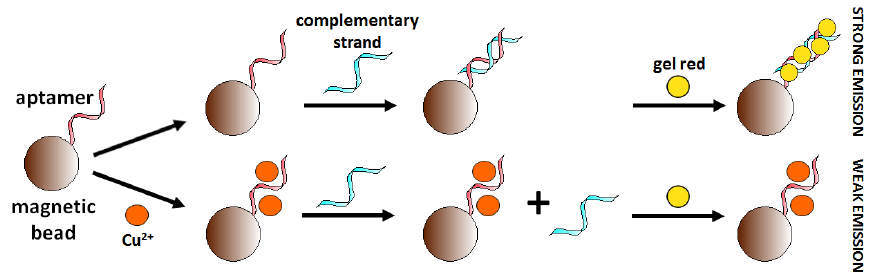
Figure 21. Scheme of the fluorescent aptasensor for copper ions.